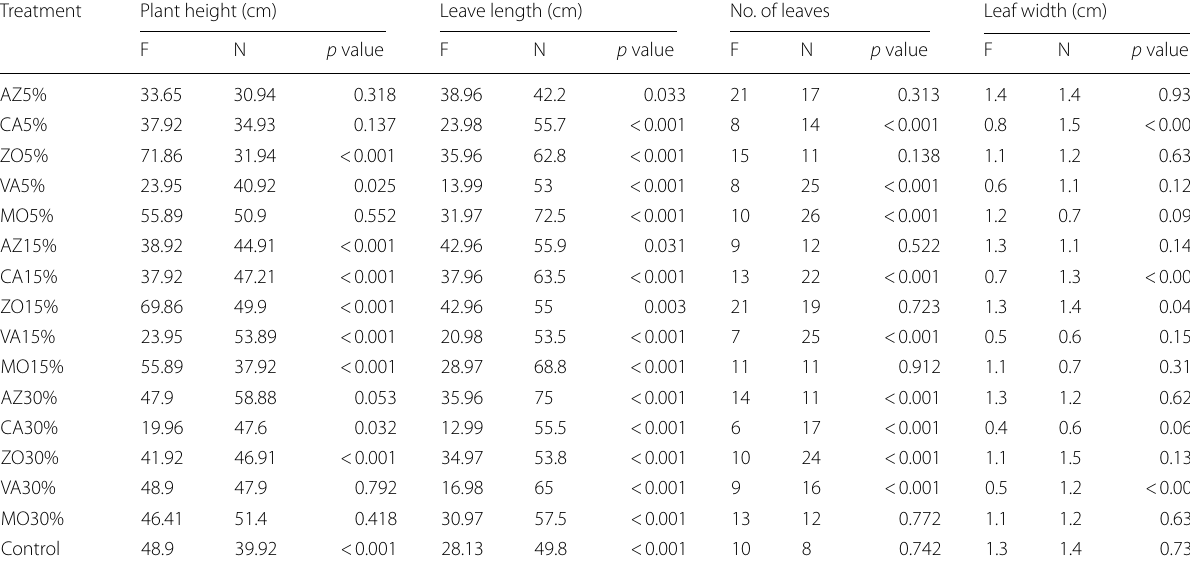
CA Carica papaya, VA Vernonia amygdalina, MO Moringa oleiofera , AZ Azadiracta indica ZO Hibiscus sabdariffa